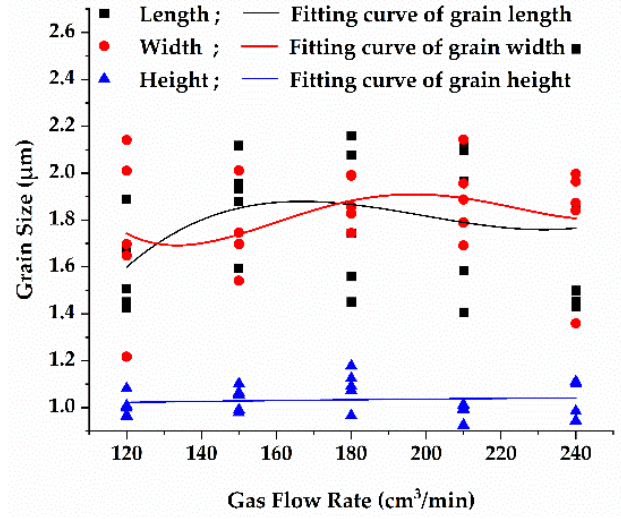
Figure 5. Effect of gas flow rate on active grain size. Figure 6 shows the size distribution and variation trend of the length, width, and height of the active abrasive grains in different reaction spaces. The fitted equation of the (cid:0) (cid:0) (cid:1) (cid:1) y = 1.34476 + 0.00441 x − x 2 length of abrasive grains is 6.37153 × 10 − 6 , which shows that with the increase of reaction space, the length of abrasive grains followed a trend of first increasing and then decreasing.